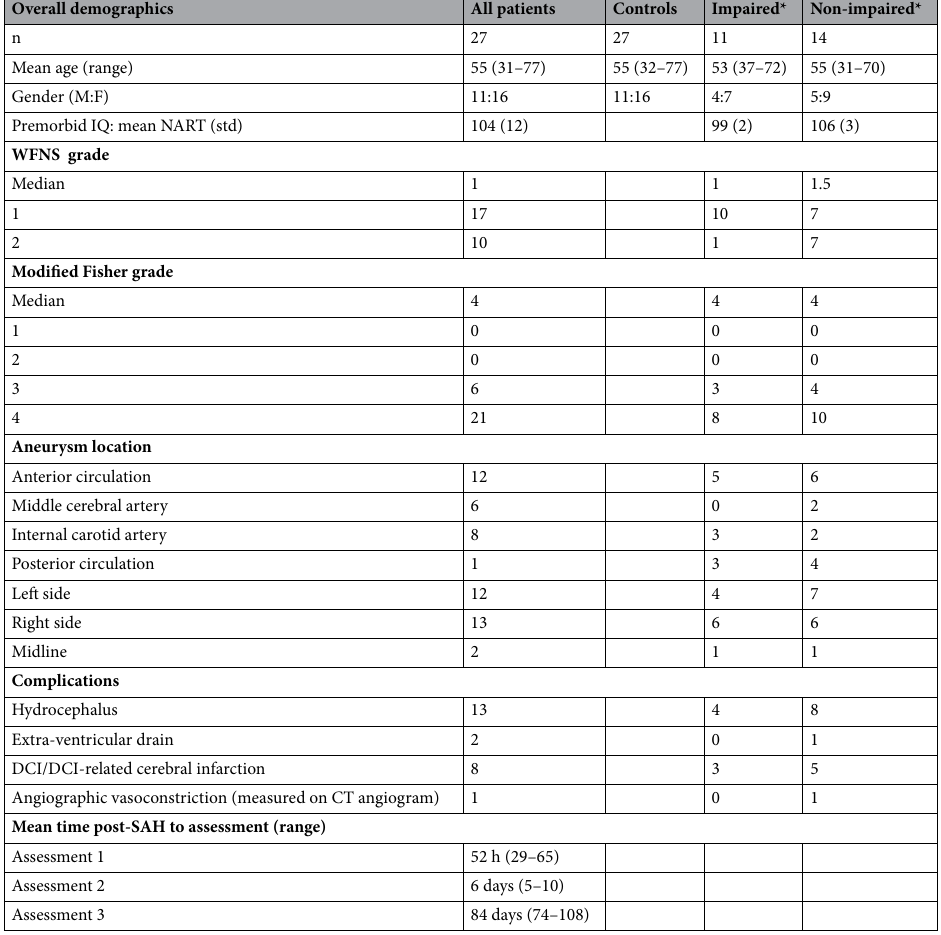
Table.1. Demographics of the scanned patients and controls (*2 patients did not undergo cognitive